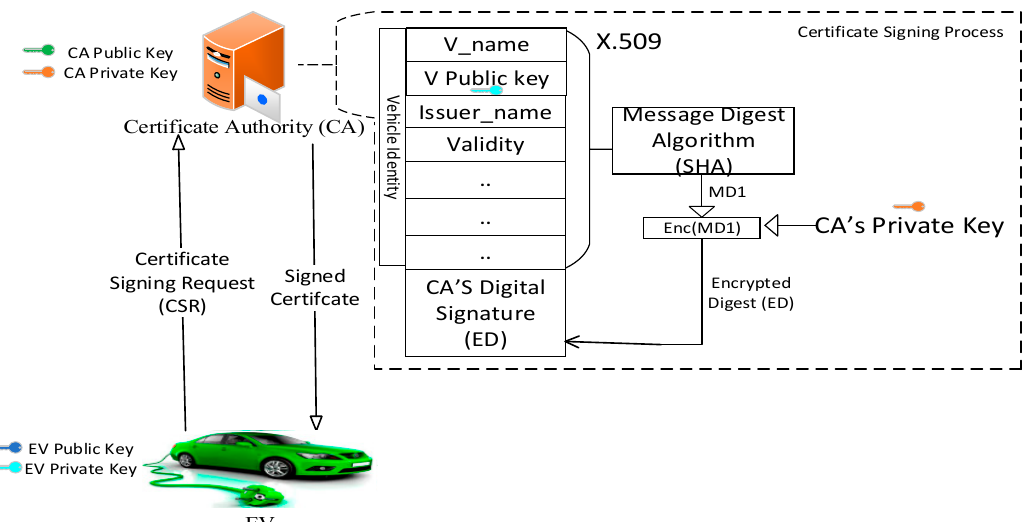
Figure 4. Certificate signing of electric vehicle (EV) by certificate authority (CA).